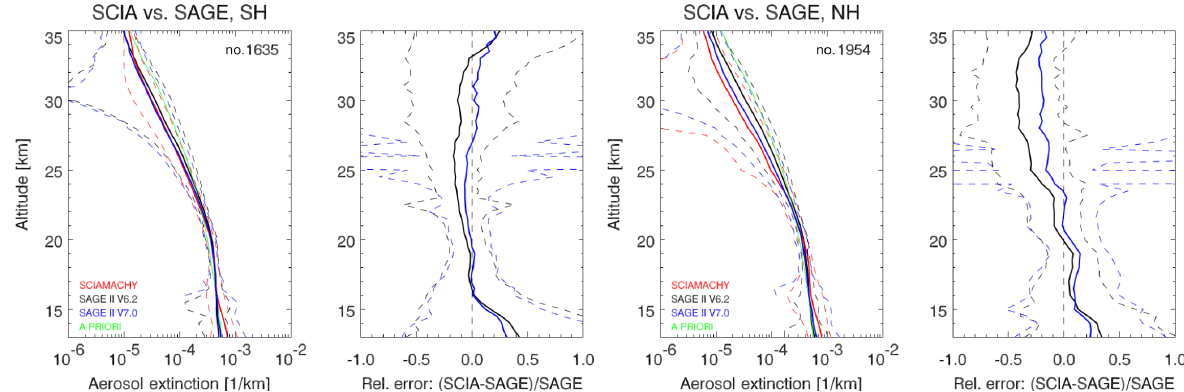
Figure 2. Similar to Fig. 1 but separated into Southern Hemisphere co-locations (left panels) and Northern Hemisphere co-locations (right panels) of SCIAMACHY and SAGE II measurements. Table 1. Relative difference (%) of the SCIAMACHY aerosol extinction with respect to co-located SAGE II measurements, both averaged in 8 latitude bins and given in 5-%